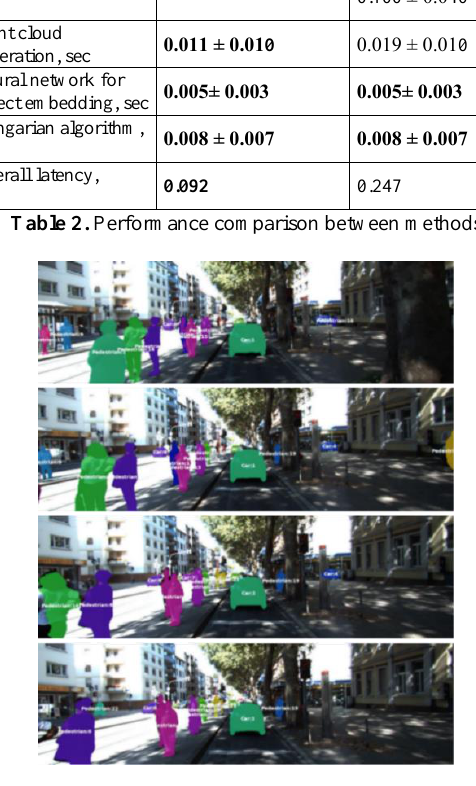
(a) SOLOv2 ResNet34 + PointTrack (modified)